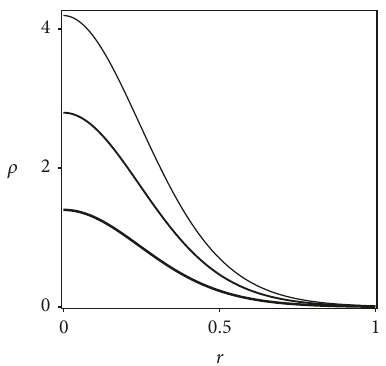
Figure 3: The profile of the energy density in (34) for 𝑠 = 8 and 𝛼 = 0.1, 0.15 , and 0.2 . The thickness of the lines increases with 𝛼